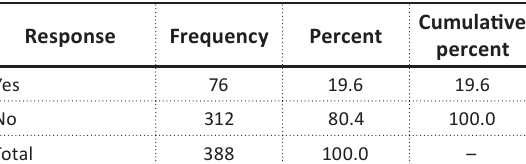
Table 1. Response on affiliation of stokvels to